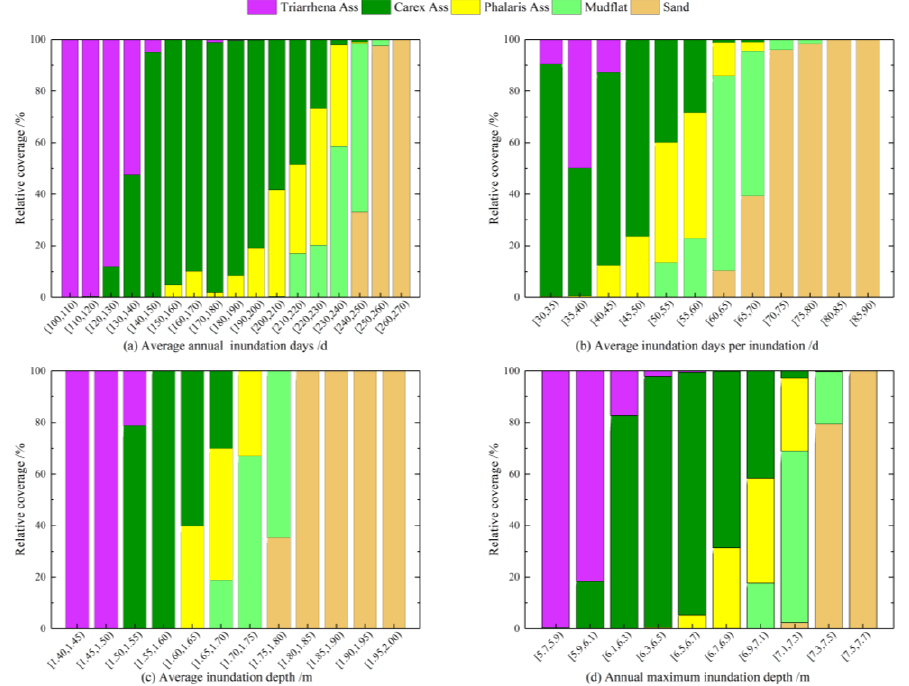
Figure 7. The area fraction of each plant community based on the statistics of the ( a ) annual average inundation days (d), ( b ) average inundation days per inundation (d), ( c ) annual average inundation depth (m), and ( d ) annual maximum inundation depth (m) in the study area.